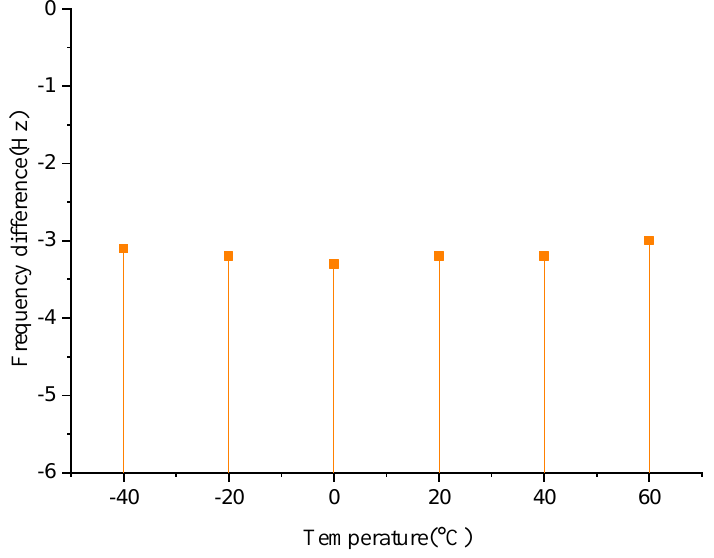
Figure 12. The frequency difference between the two DETFs under different